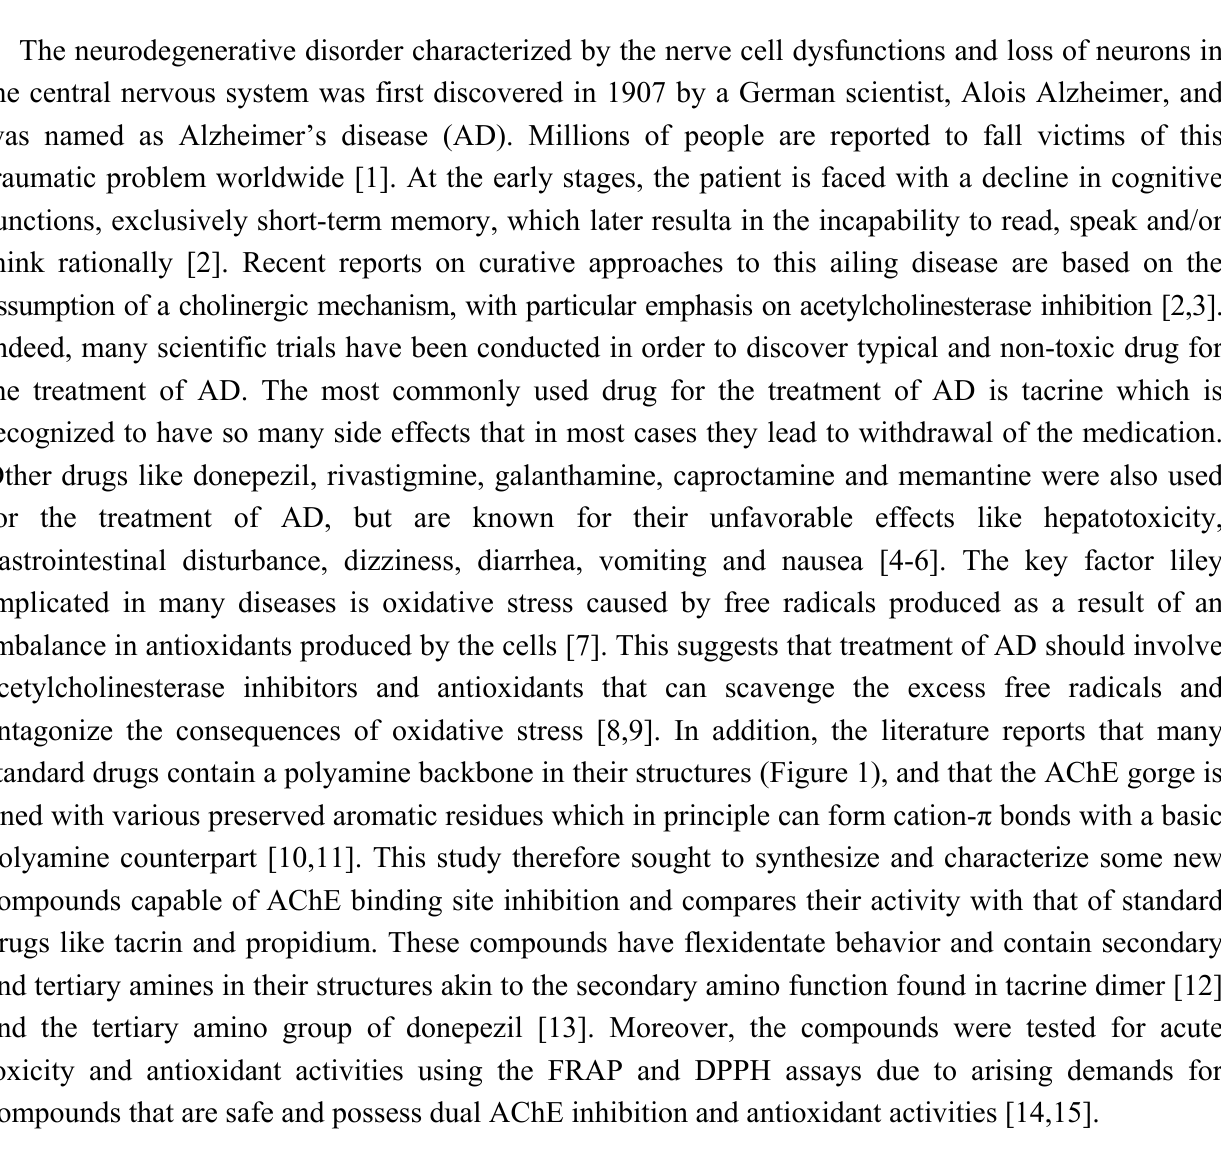
Figure 1. Acetylcholinesterase